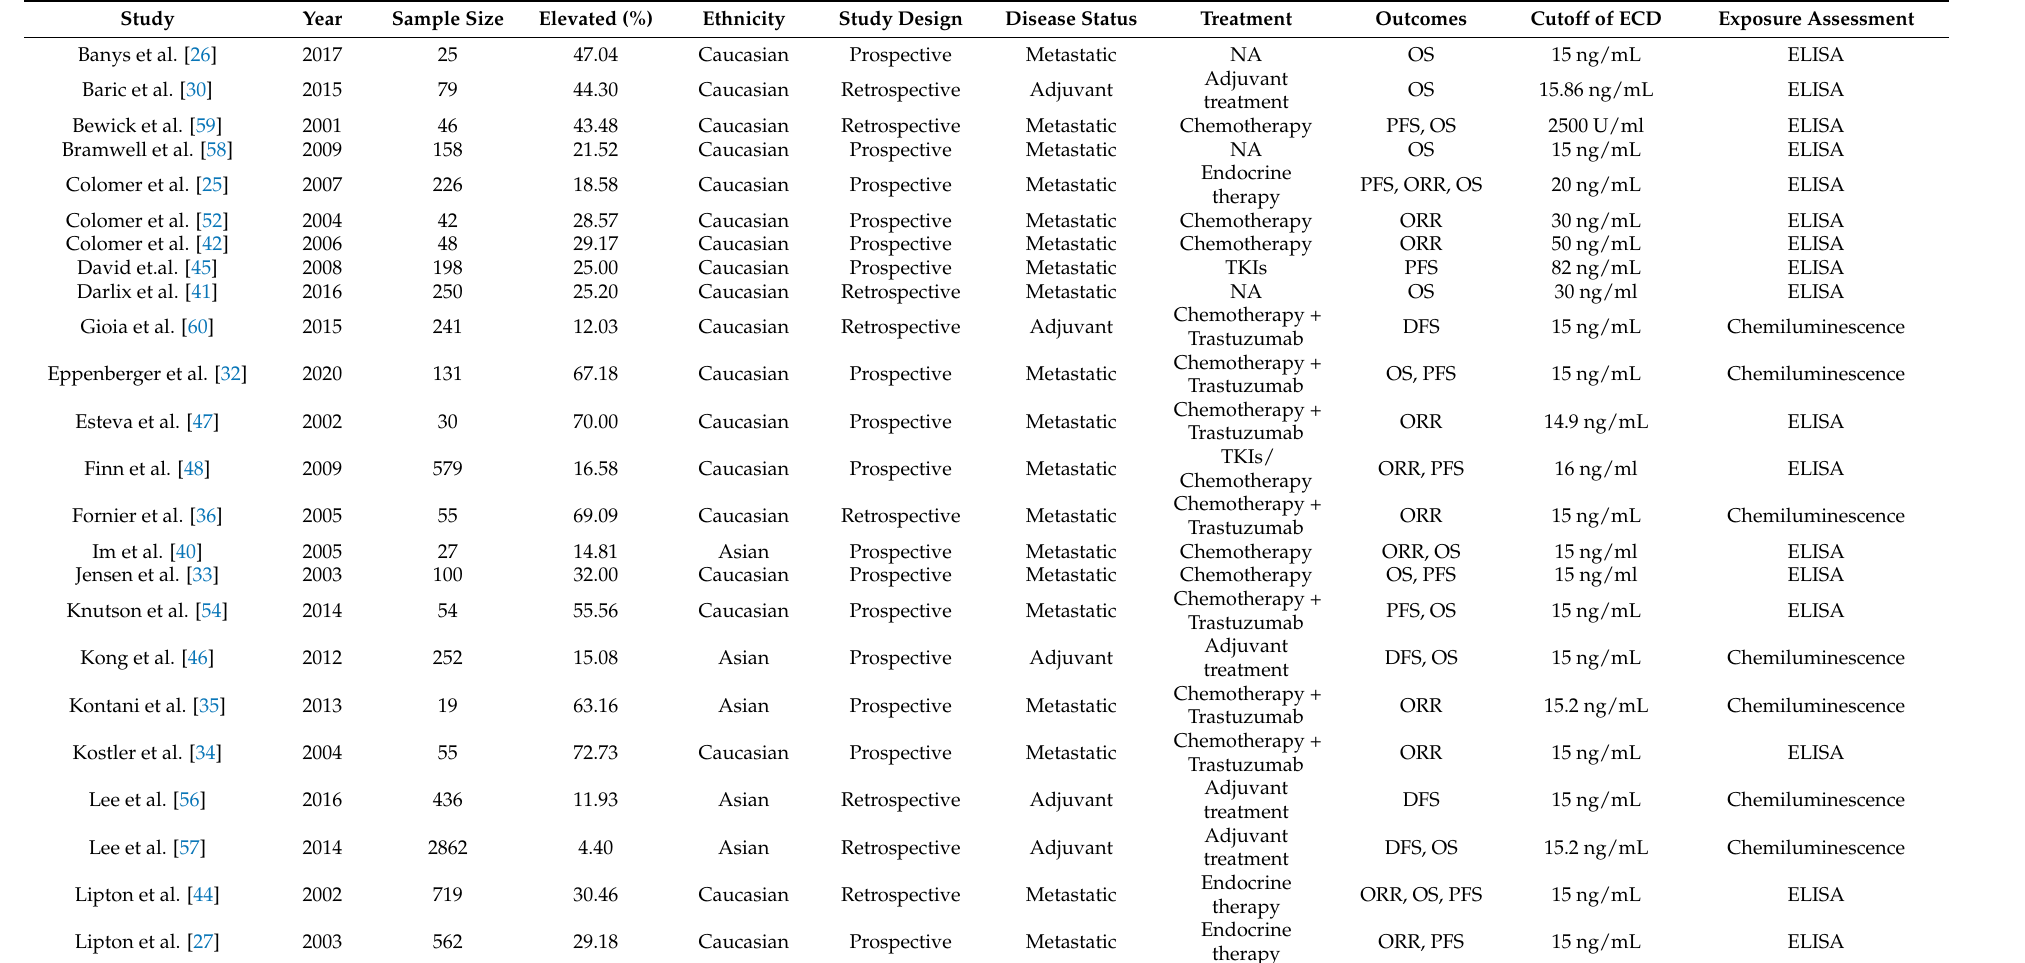
Table 1. Baseline characteristics of the studies included in the systematic review and